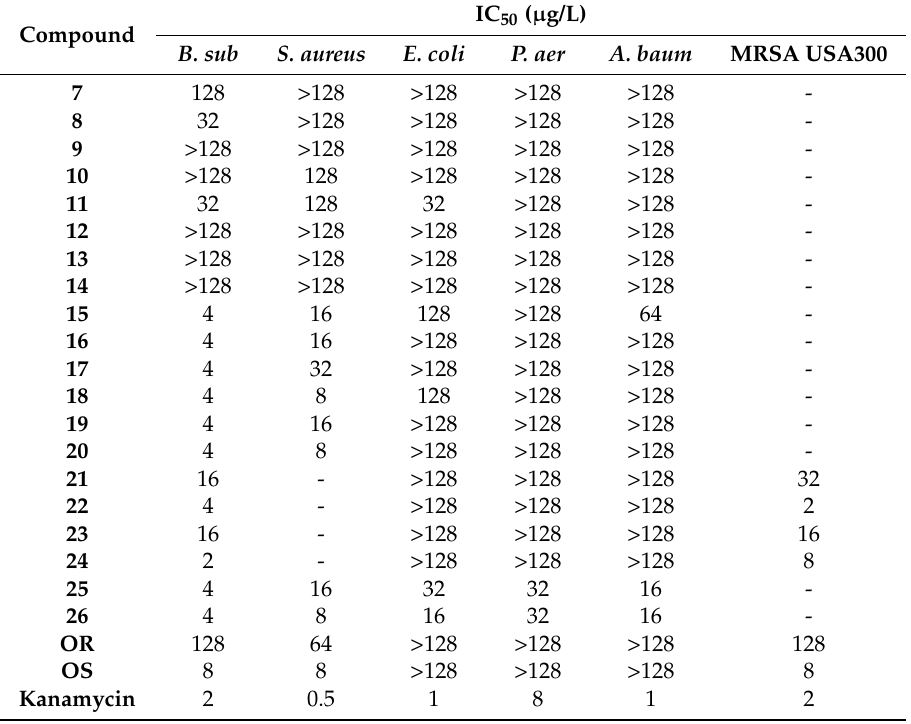
Table 1. In vitro antibacterial activity of ocotillol-type derivatives 7 – 26 against B. subtilis 168, S.